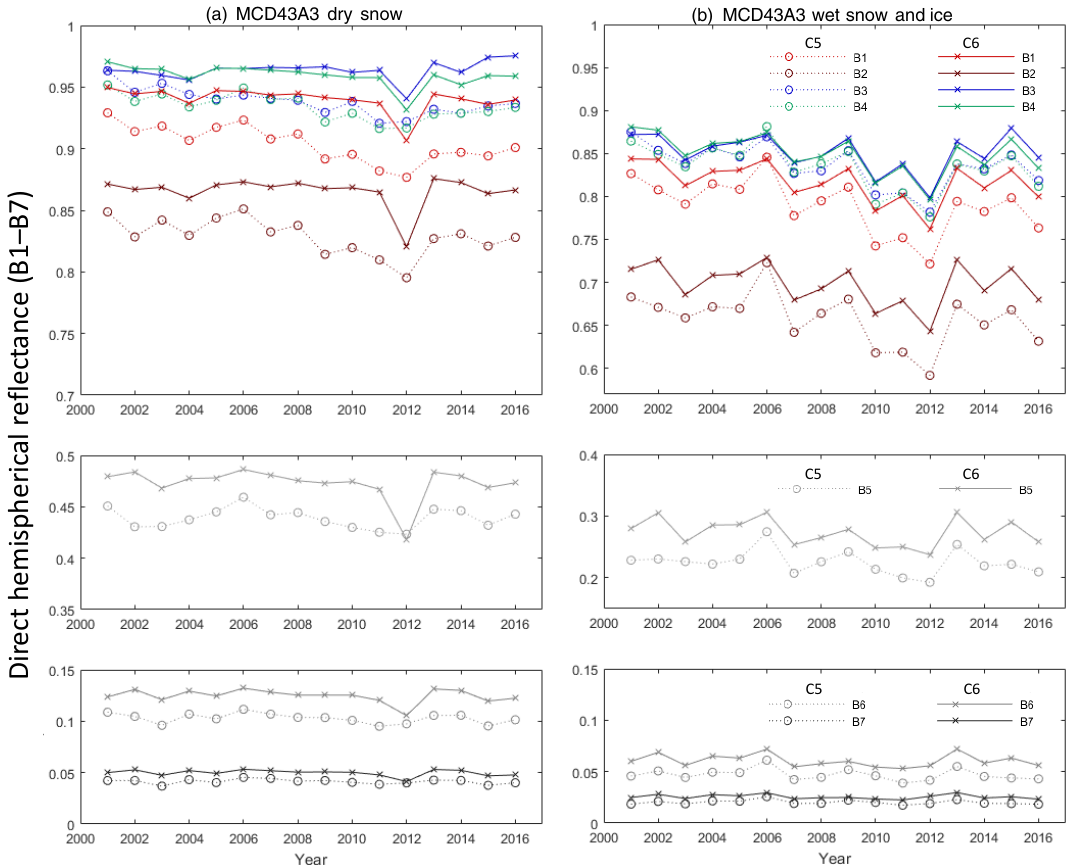
Figure 4. Greenland Ice Sheet average summer (1 June–31 August) MCD43A3 BSA C5 and C6 band 1–7 albedo for dry (a) and wet snow and ice (b) . (Note the y -axis scale is different for dry vs. wet snow and ice for B1–4 and B5). Interestingly, there is a separation in C5 to C6 B1, B2, B4, B5 and B6 albedo values throughout the MODIS